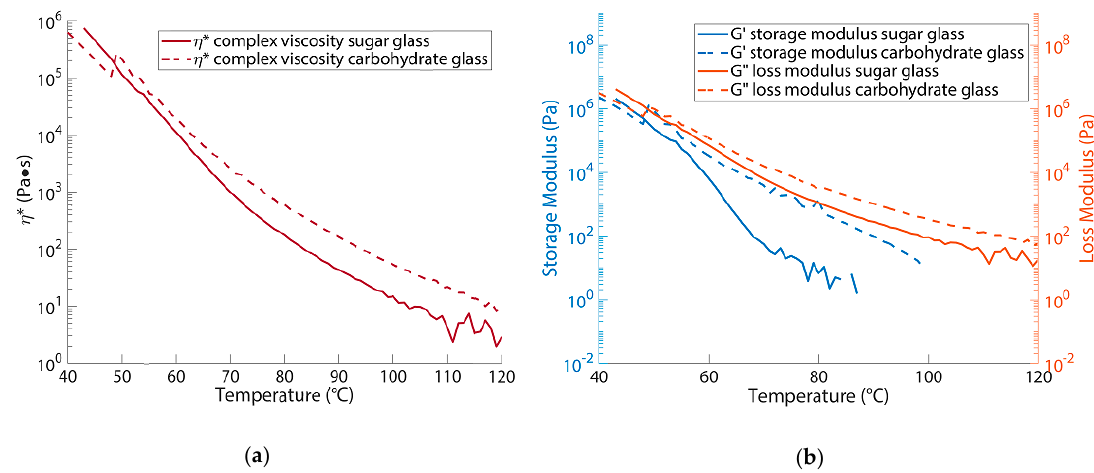
Figure 2. Rheological behaviour of sugar and carbohydrate glass: ( a ) Complex viscosity ( η *) on a logarithmic scale for both blends as function of temperature measured at a frequency of 1 Hz. The carbohydrate glass shows a higher viscosity compared to the sugar glass—important for the temperature during fibre printing; ( b ) Storage (G’) and Loss (G”) modulus on a logarithmic scale for both blends as function of temperature. The storage modulus (G’) of carbohydrate glass is increased several orders of magnitude, making fibres less prone to breaking and necking during printing.